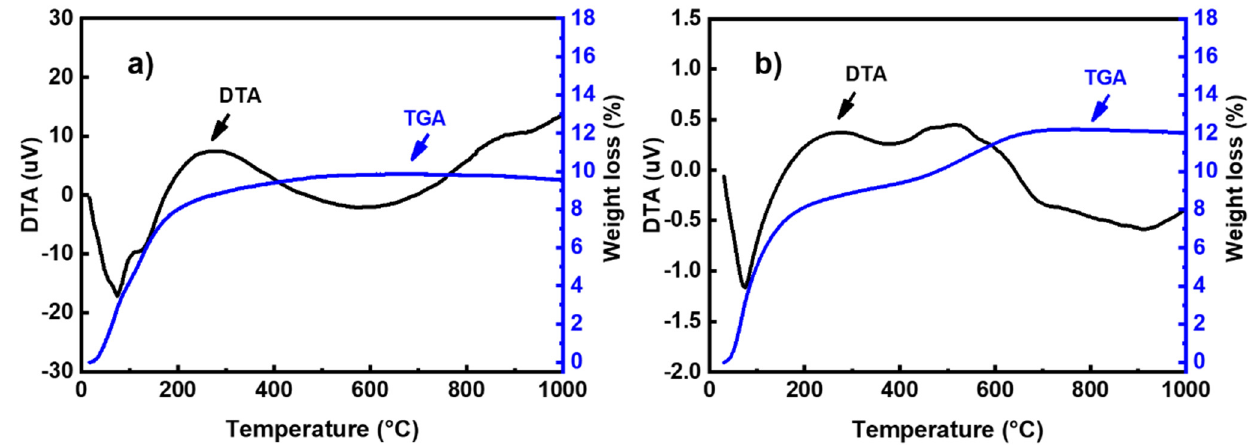
Figure 7. TGA/DTA curves of ( a ) BGMK and ( b ) BGFA geopolymer binders.